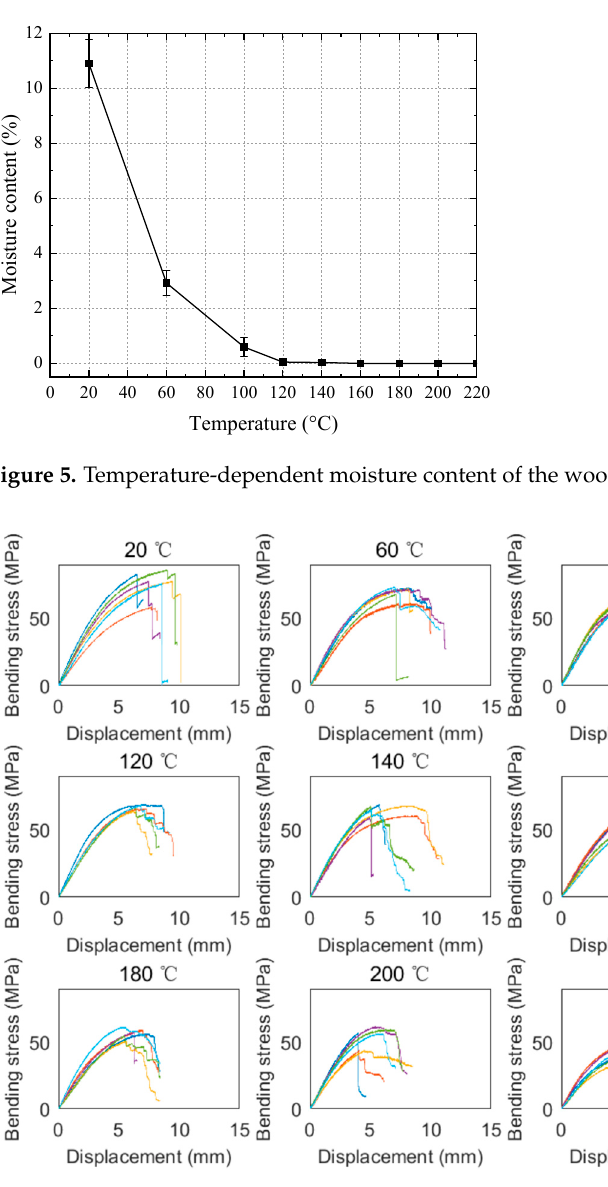
Figure 6. Bending stress–displacement curves at different temperatures.